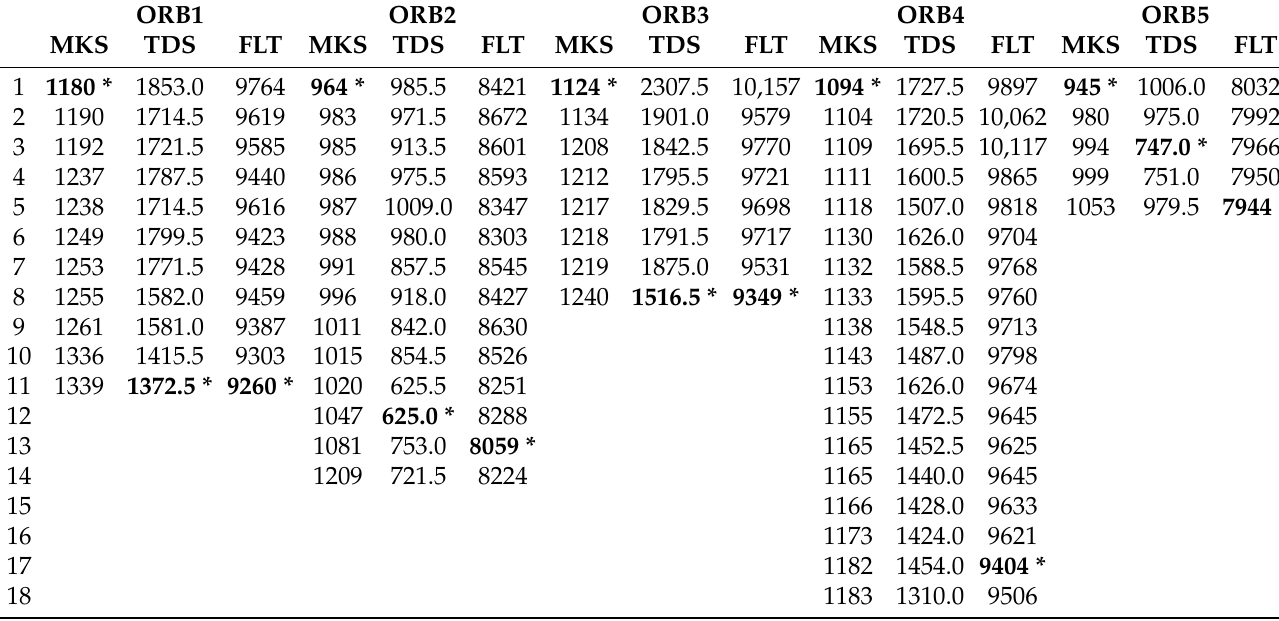
Table A8. Non-dominated front obtained by CMOTA for the JSSP instances proposed by